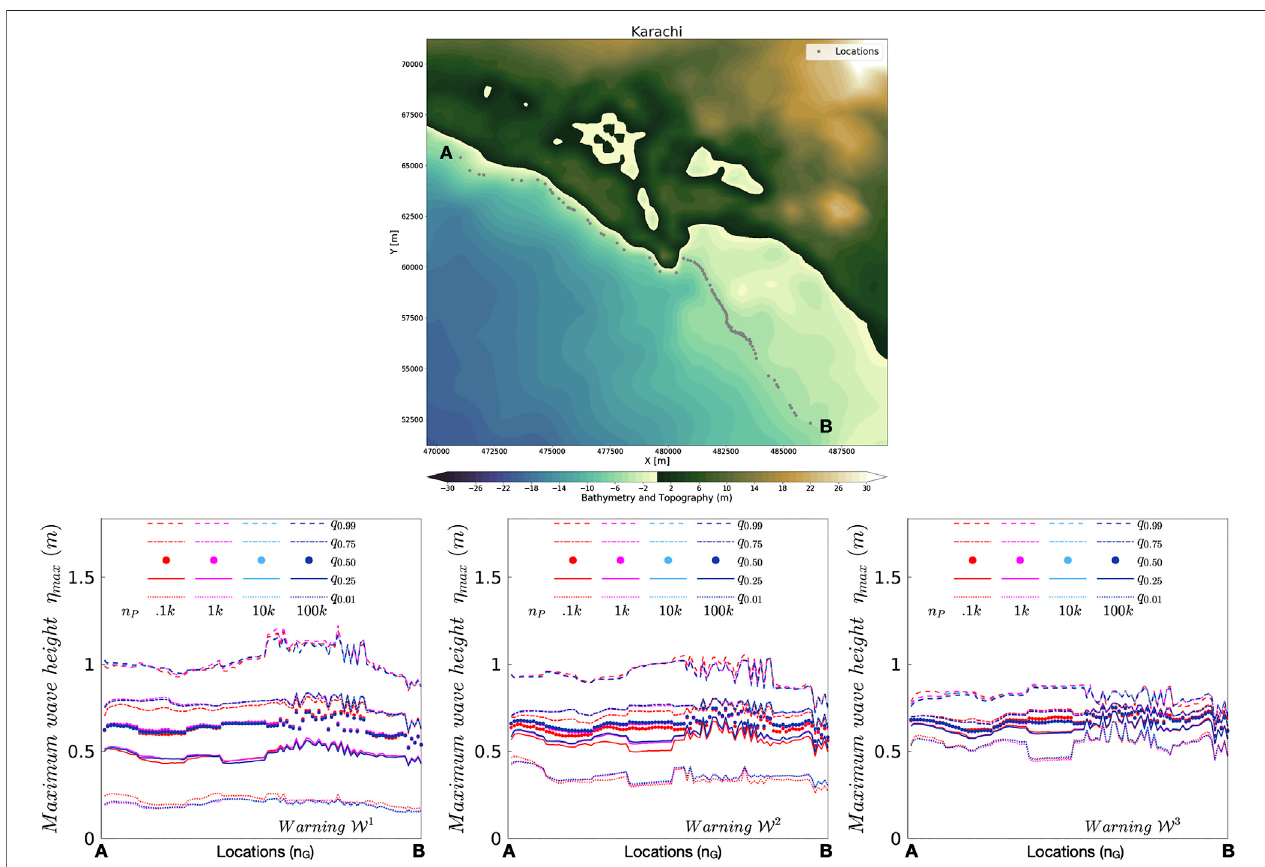
FIGURE9| Uncertainty atgaugesalongthecoastlineofKarachi. Toprow: Locationof100gaugesorderedfromAtoB. Bottomrow: Boxplotsforthemaximum wave height η max at the 100 gauges, for fi rst (left) , second (middle) and third (right) warning stages. A boxplot for a gauge portrays the distribution of predicted η max using the emulator via the quantiles for probabilities of 1, 25, 50, 75, and 99%. Superimposed on each plot are the distributions of the predicted η max for four sets of samples from the priors (see Figure 6 , Bottom row), i.e., for n P (cid:2) 0.1 k , 1 k , 10 k , and 100 k .